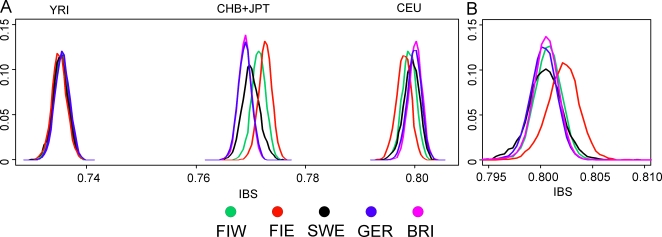
Distributions of pairwise identities by state.IBS between the five studied populations and each HapMap population (a) and within the populations (b). Within the four groups of comparisons, all distribution pairs differed significantly (p<4.6×10−4 for comparisons within the populations, p<10−14 with CEU and with CHB+JPT, and p<0.025 with YRI) except that in the comparisons with Asians, Germany and Great Britain did not differ. Abbreviations as in Figure 1.